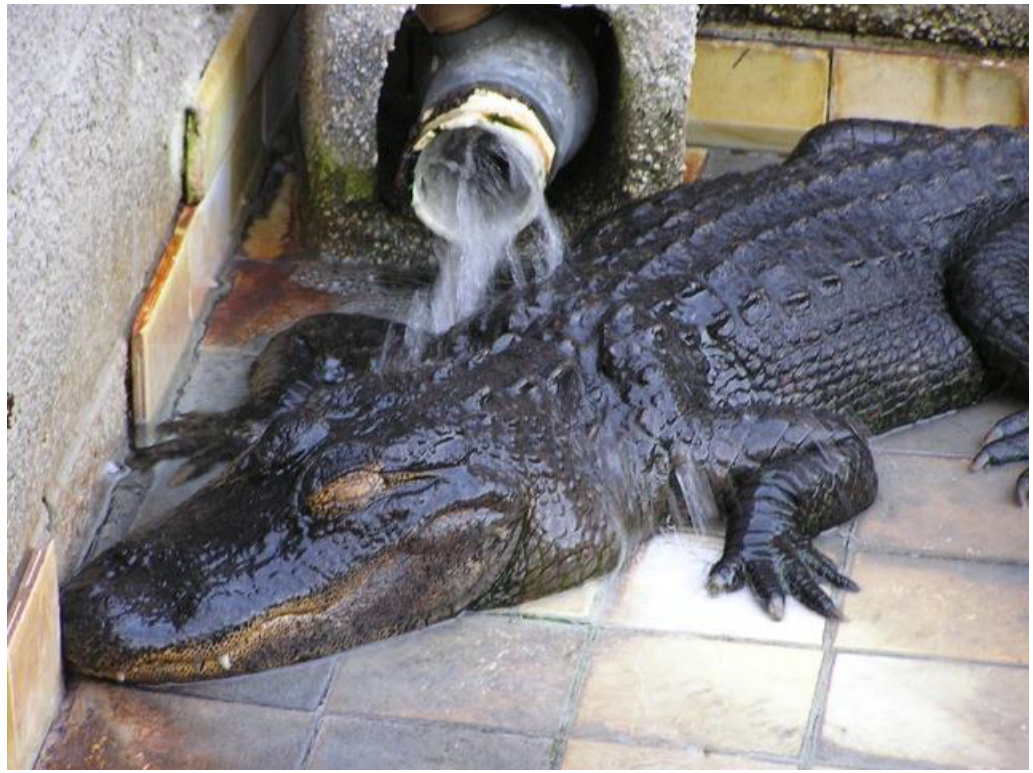
Figure 1 . An American alligator ( Alligator mississippiensis ) resting after a bout of play with a stream of water, Saint Augustine Alligator Farm Zoo Park, Florida,